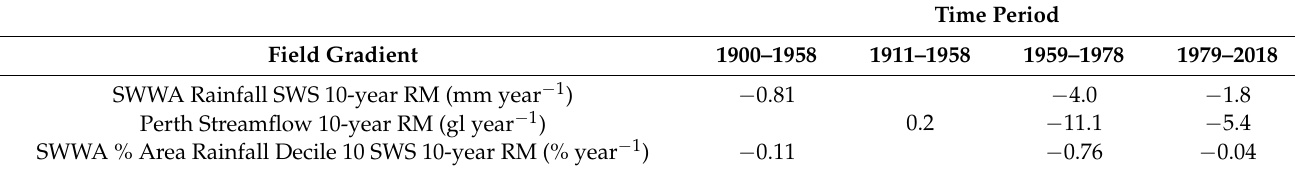
(PAR D10 ) for different time